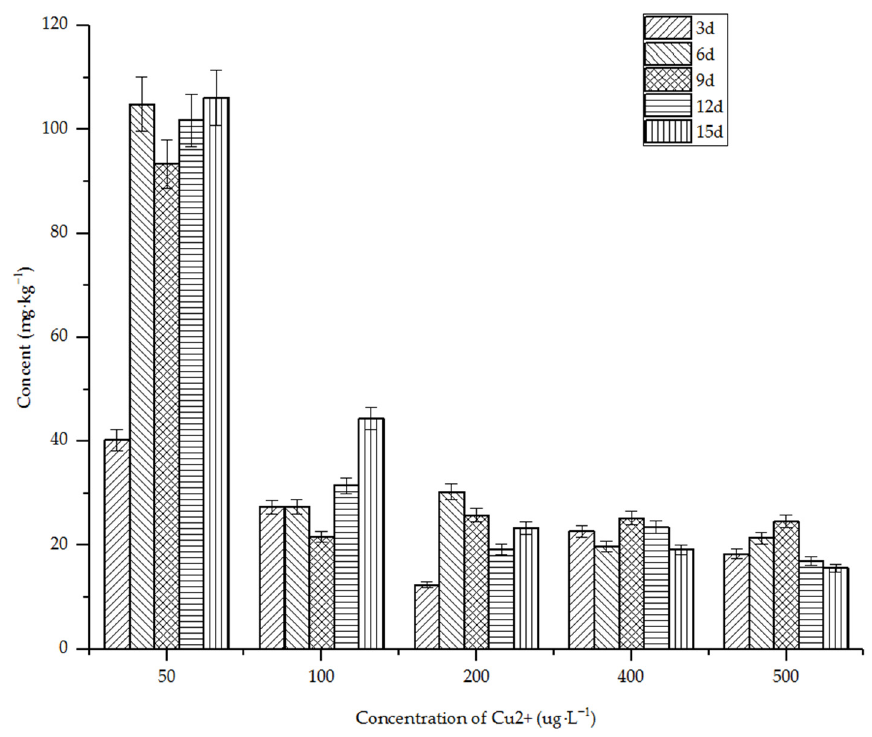
Figure 5. Absorption of heavy metal copper ions by Suaeda salsa.